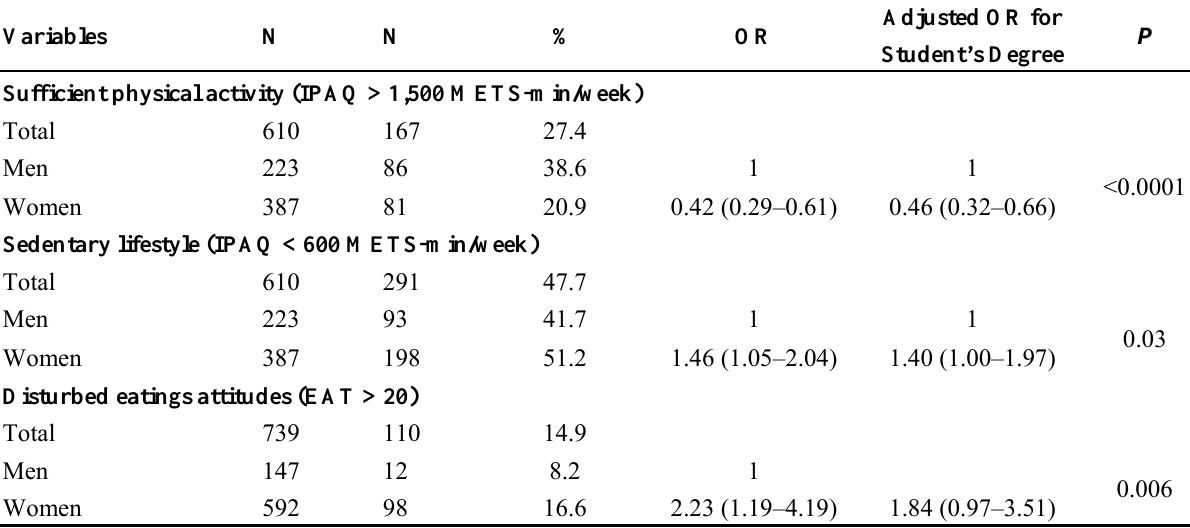
Table 2. Descriptive statistics of health-related behaviours analyzed by gender and crude OR and adjusted for student’s